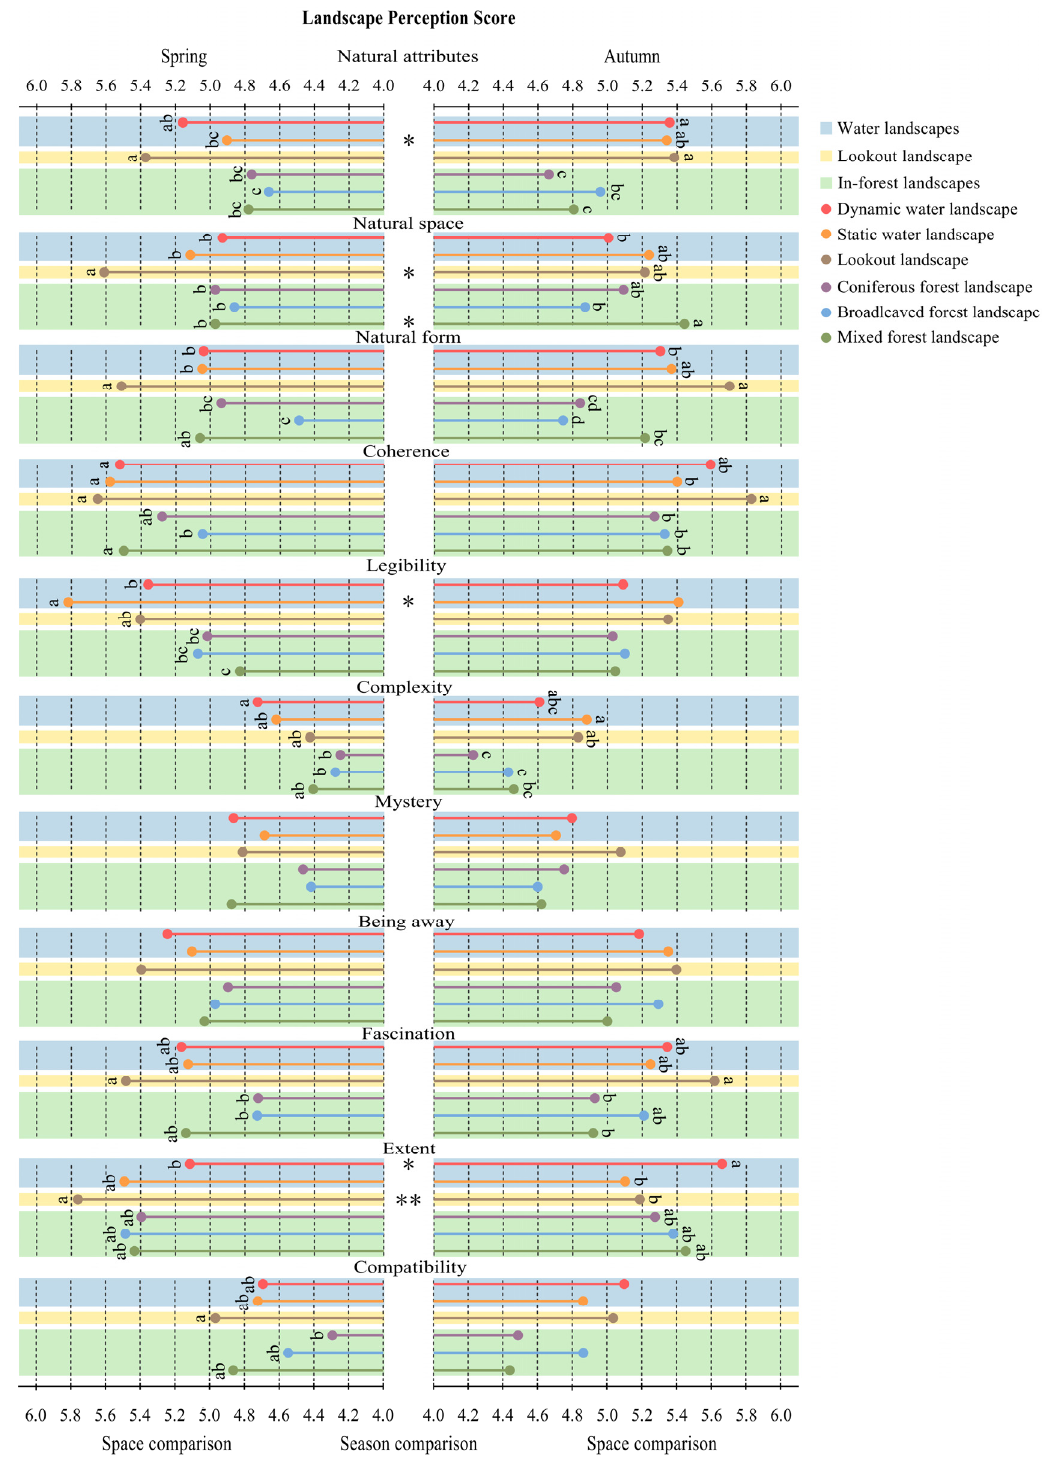
Figure 5. Comparison of mean scores of the Perceived Naturalness Scale, Environmental Preference Scale and Perceived Restorativeness Scale. Perceived naturalness scale: natural attributes, natural space and natural form. Environmental preference scale: coherence, legibility, complexity and mystery. Perceived restorativeness scale: being away, extent, fascination and compatibility. “Lowercase letters”: significant differences ( p < 0.05) among the six spaces. “*”: significant differences between the spring and autumn; * p < 0.05; ** p < 0.01. Landscape space comparison: one-way ANOVA; Seasonal comparison: independent-samples t test. This figure was created by Rui Chen.